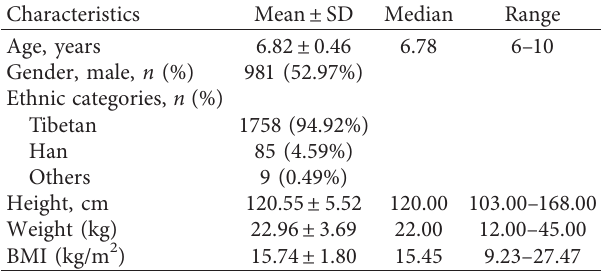
Table 2: Characteristics of participants ( n � 1852).